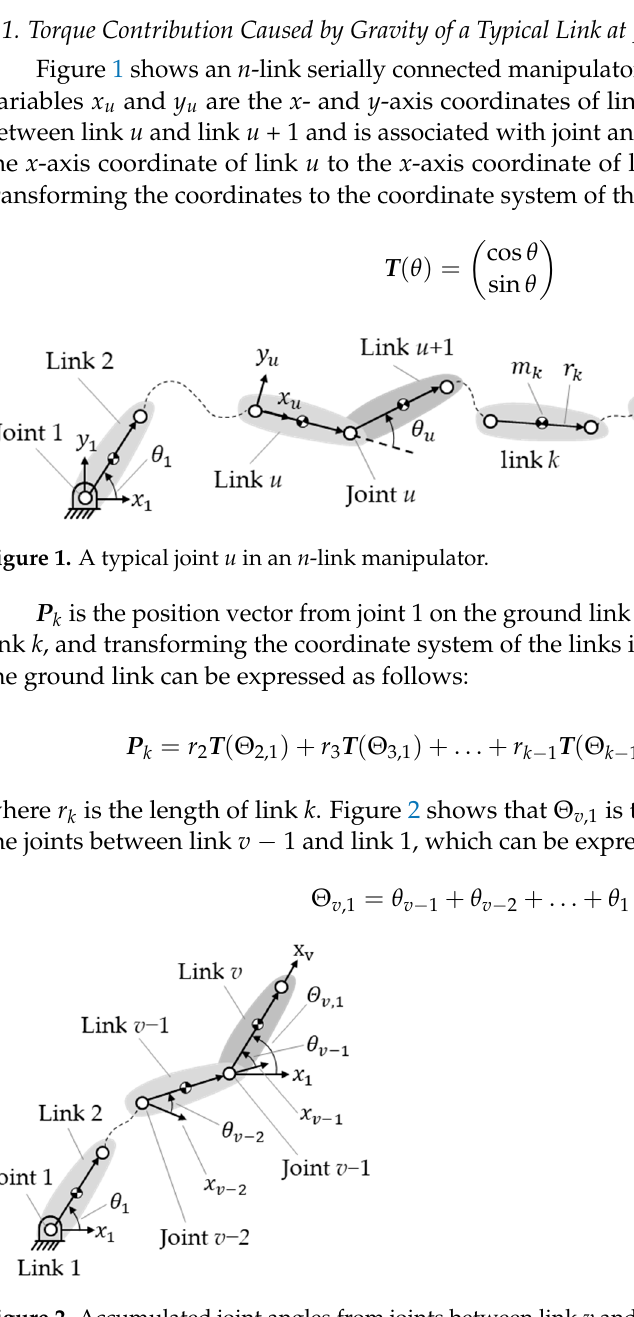
Figure 2. Accumulated joint angles from joints between link v and link